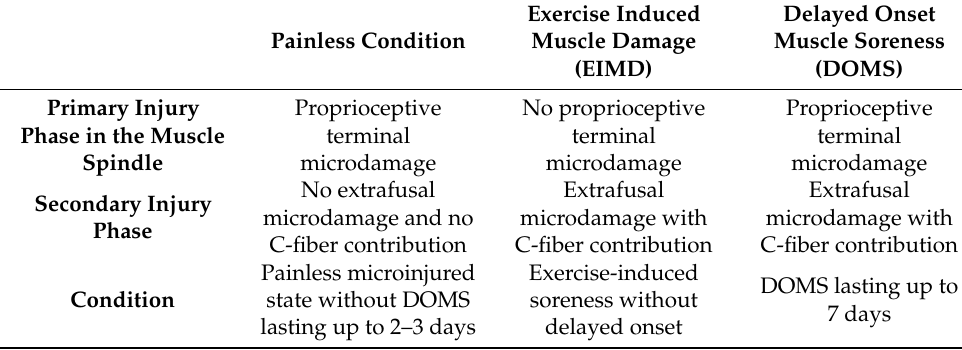
Table 2. Exercise-induced